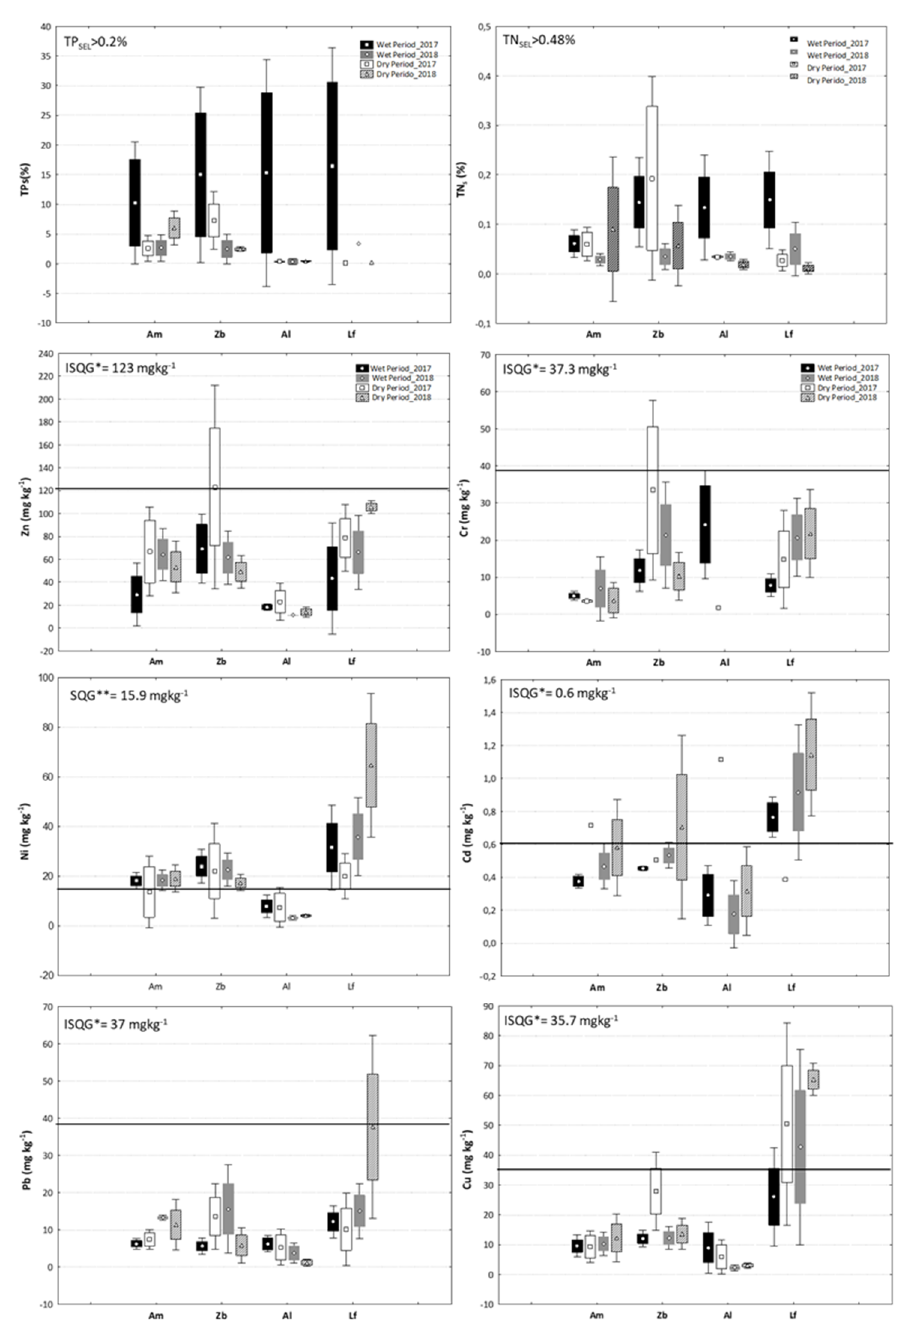
Figure 6. Variability of the nutrients and potential toxic trace elements at sediments. The mark across the box represents the mean, and the bottom and top of the box show the standard deviation. Guide levels were from: Severe Effect Level (SEL) Ontario Sediment Quality Guidelines [54]; Canadian Interim Freshwater Sediment Quality Guideline (ISQG) for the Protection of Aquatic Life [55]; Sediment Quality Guideline (SQG; [56]).